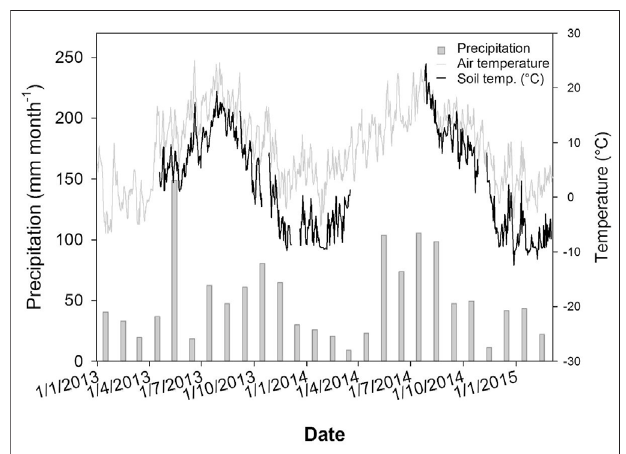
FIGURE 1 | Air temperature ( ° C), mean soil temperature (5 cm) ( ° C) and precipitation(mm month − 1 ) fromJanuary2013toMarch 2015 at theresearch site